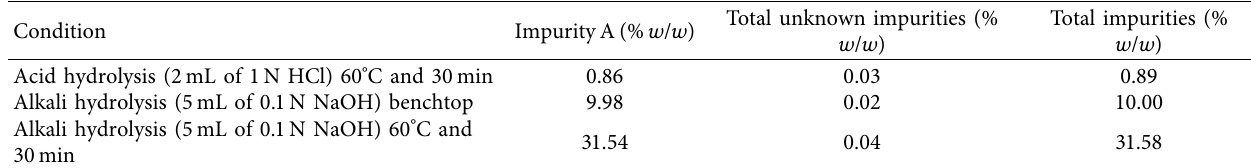
Table 4: Forced degradation data of neostigmine methylsulfate